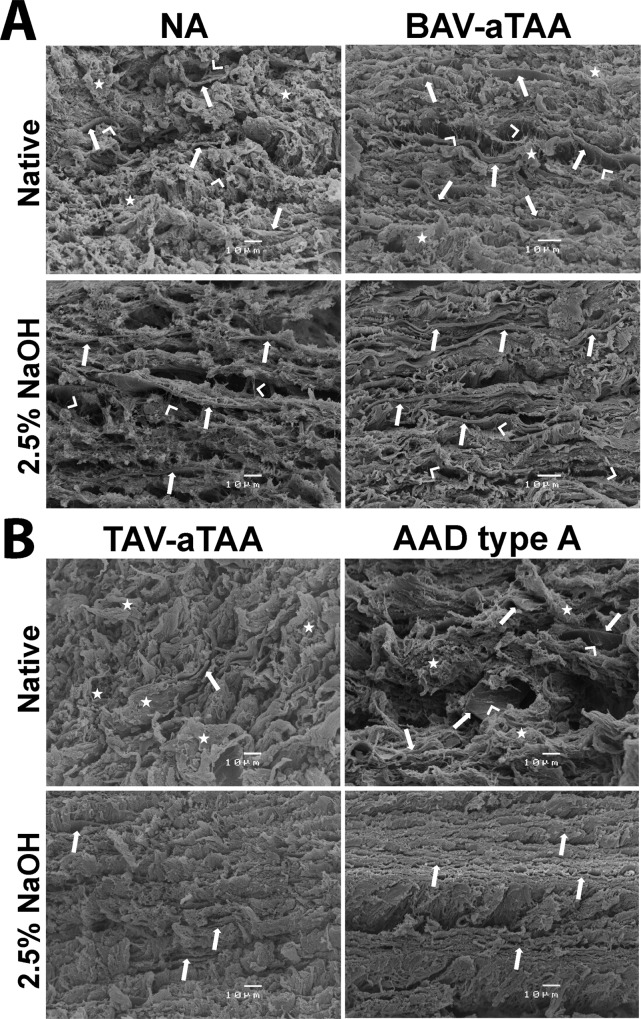
SEM based evaluation of elastic fiber sheets and other ECM components of NA and aneurysmal/dissection tissues.In (A) representative SEM pictures of native (upper row) and decellularized tissue (lower row) of controls (NA) and BAV-aTAAs are shown. In (B) SEM pictures of native and decellularized TAV-aTAAs tissue as well as tissue from a patient with an aortic dissection (AAD type A) are shown. White arrows are indicating elastic fibers, white asterisks are indicating cellular material, and white arrowheads are indicating interlaminar elastin fibers.